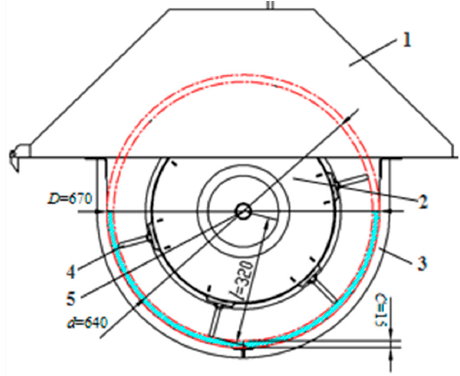
Figure 1. Schematic diagram of the threshing device of YANMAR-AW82G combine harvester: 1—top cover; 2—threshing cylinder; 3—concave grid; 4—threshing cylinder tooth; 5—shaft; D and d are the diameters of the concave grid and threshing cylinder respectively, mm; C is the threshing gap, mm; l is the elongation of threshing rod (distance between the outer end of the threshing cyl- inder teeth and the center of the shaft), mm. Table 1. Combination method of the threshing rod elongation.